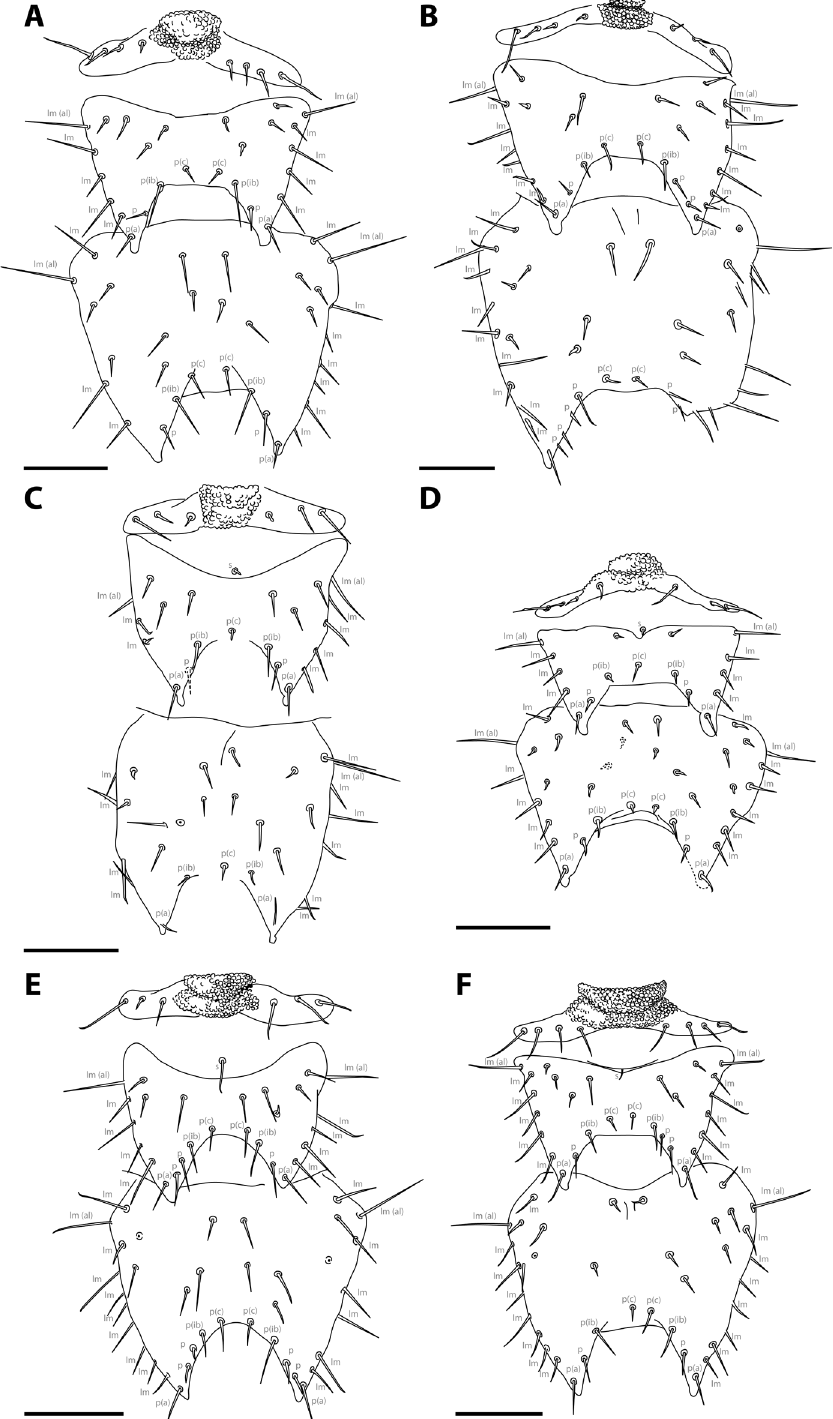
Fig. 7. Schemata of the three first tergites and chaetotaxy of the described species of Symphylella. A . S. erecta sp. nov. B . S. fuko sp. nov. C . S. kalundu sp. nov. D . S. lubumbashi sp. nov. E . S. mala- gassa sp. nov. F . S. tanganyika sp. nov. — Marginal setae of second and third tergites labelled: lm , lateromarginal setae; lm (al) , anterolateral seta of lateromarginal; p , posteromarginal setae; p(a) , apical setae – belonging to the posteromarginal setae; p(c) , central setae of posteromarginal; p(ib), inner basal setae of posteromarginal; s , seta between first and second tergites. Scale: 50